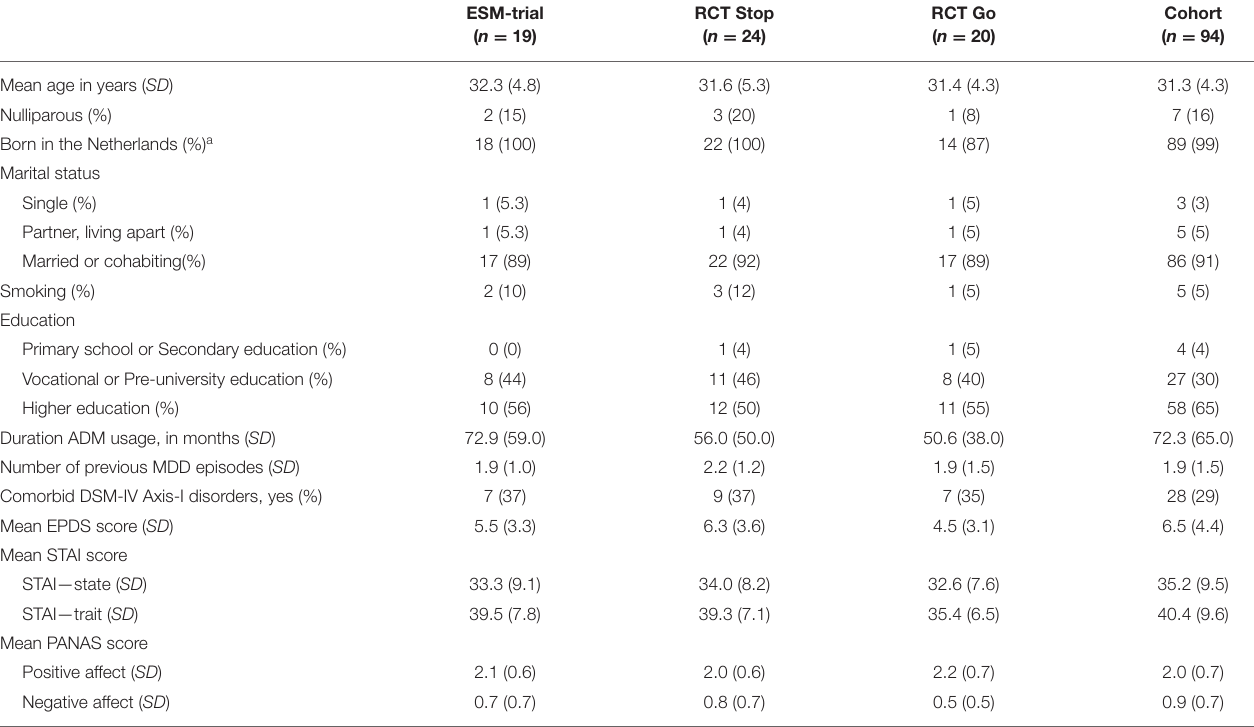
TABLE 1 | Baseline participant characteristics.